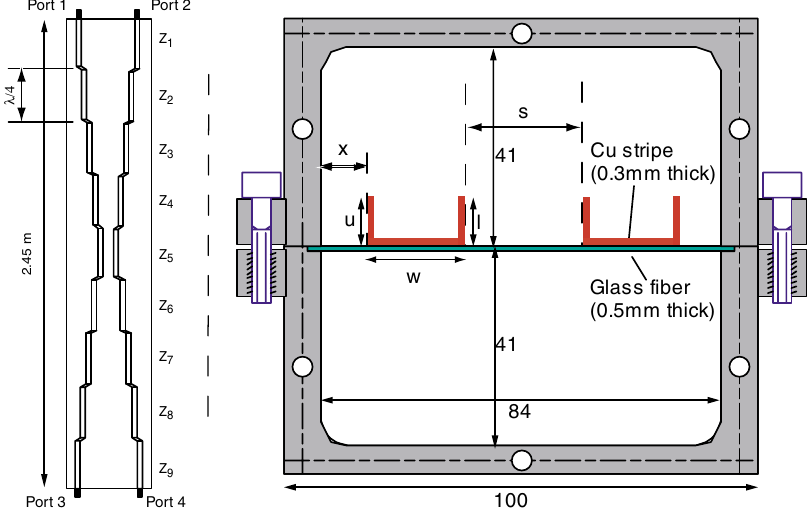
FIG. 9. (Color) Top view (left side) and cross section (right side) of the coupler. The left side shows the layout of the coupler with with i (cid:1) 1 ; . . . ; 9 ). Since the coupler is symmetric, Z the nine sections (referred to as Z i shows the copper strips’ parameters ( w , u , and l ) and their positions ( x and s ). These change for each section in order to obtain the appropriate impedance values. All distances are given in